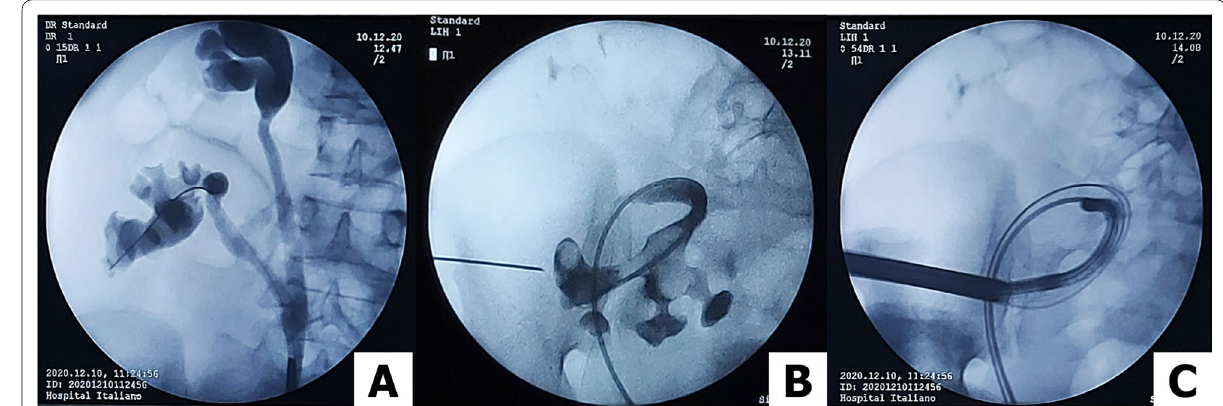
Fig. 3 A Right native (upper kidney) and right flank transplanted kidneys dilated due to ureteral stones impacted in the uretero-ureteral end-to-side anastomosis. B Open-end ureteral catheter ascended after catheterization of the ureteroneocystostomy. Upper pole puncture of the right iliac fossa transplanted kidney under ultrasound guidance. C Antegrade flexible nephroscopy assessing residual fragments after finishing the percutaneous